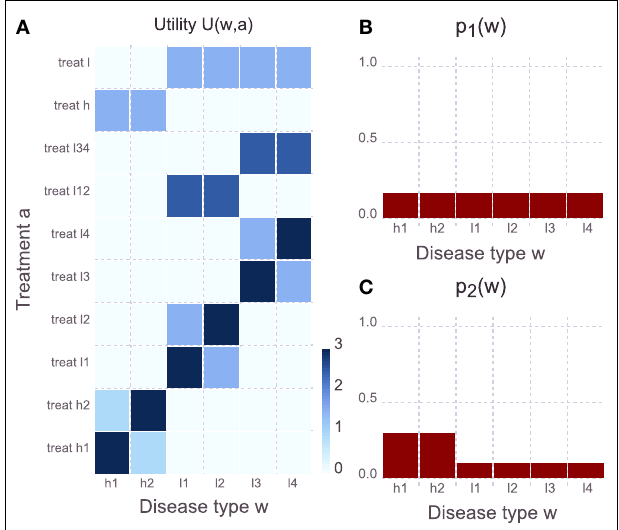
FIGURE 9 | Task setup of the medical system example . (A) Utility function. The disease category heart disease comes in the two types h 1 or h 2. There are two different categories of lung diseases that come in types l 1 or l 2 (lung disease A ) or types l 3 and l 4 (lung disease B ). The goal of the medical system is to gather information about the disease type and then initiate a treatment. Each of the disease types is best treated with a specific treatment. However, when the specific treatment is applied to the wrong disease type of the same disease category it is less effective. Additionally there are general treatments for the heart- and the two lung diseases that are slightly worse than the specific treatments but can be applied with less knowledge about the disease type. For lung diseases, there is a general treatment that works even if the specific lung disease is not known; however, it is less effective compared to the treatments where the disease but not the precise type is known. (B) Distribution of disease types in environment 1 – all diseases appear with equal probability. (C) Distribution of disease types in environment 2 where the heart diseases have an increased probability and the two corresponding disease types appear with higher